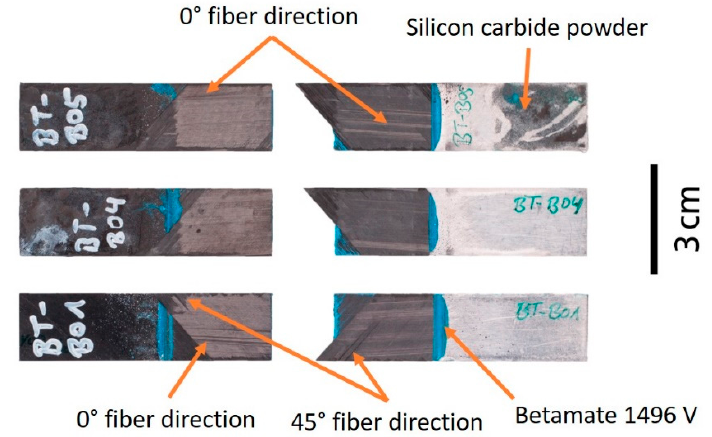
Figure 13. Multi-material bonded joints after